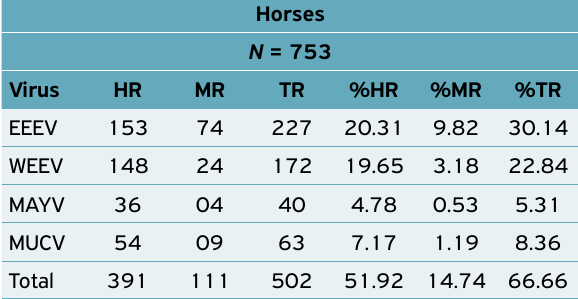
Table 1. Prevalence of HI antibodies against antigens of four alphaviruses in horses sera with heterotypic reactions (HR), monotypic reactions (MR), and total reactions (TR) obtained in State of Pará, Brazil. Horses N =